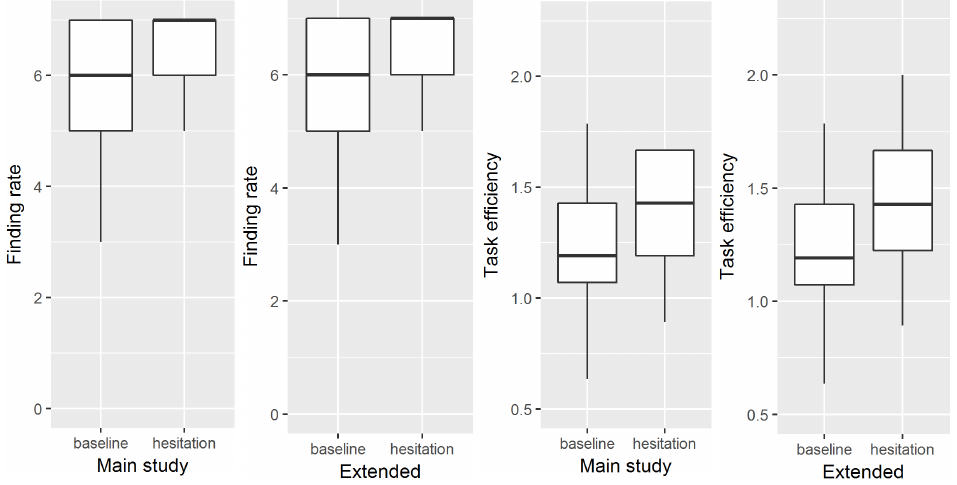
Figure 5. Task performance and